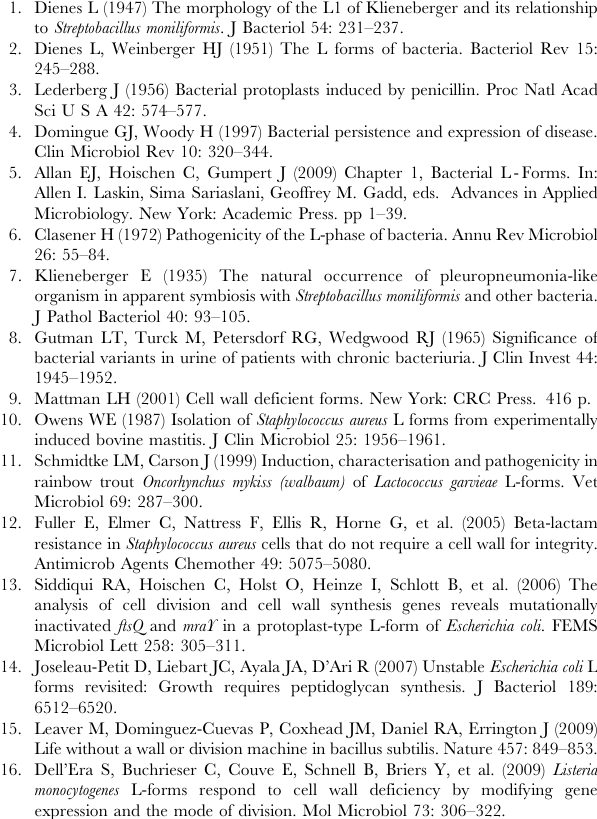
Table S2 Genes repressed 4-fold and higher in E. coli L-form colonies versus classical colonies